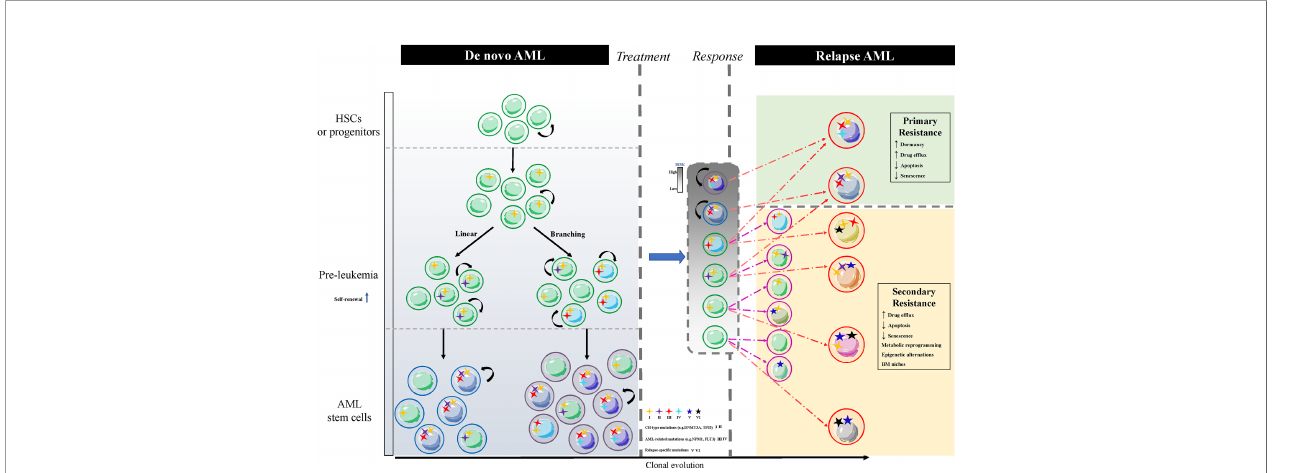
FIGURE 1 | The schematic of LSCs clonal diversi fi cation resulting in AML relapse. The normal HSCs or progenitor cells carry CH-type mutations without proliferative potentials, such as ‘ DTA ’ mutations, denoted by the number I, and convert to pre-leukemia HSCs or progenitor cells with enhanced self-renewal through acquiring additional genetic mutations, which are divided into linear and branching patterns of clonal evolution. The former stepwise acquires CH-type mutations like TP53, IDH1/2 and AML-related mutations like FLT3, NPM1. The latter parallelly acquires CH-type mutations and AML-related mutations in different cell populations. Different colors of nuclei show heterogeneous LSCs clones. Residual leukemia cells (grey box) after treatment include dominant clones LSCs and subclones leukemia cells. Relapsed AML arises from these two types of cells corresponding to the primary resistance (green box) of LSCs and the secondary resistance (yellow box) of reprogramming leukemia cells via acquiring a new relapse-driven clone. AML, acute myeloid leukemia; LSCs, AML stem cells; HSCs, hematopoietic stem cells; CH, clonal hematopoiesis; BM, bone marrow; ‘ DTA ’ mutations, mutations in DNMT3A, TET2 and